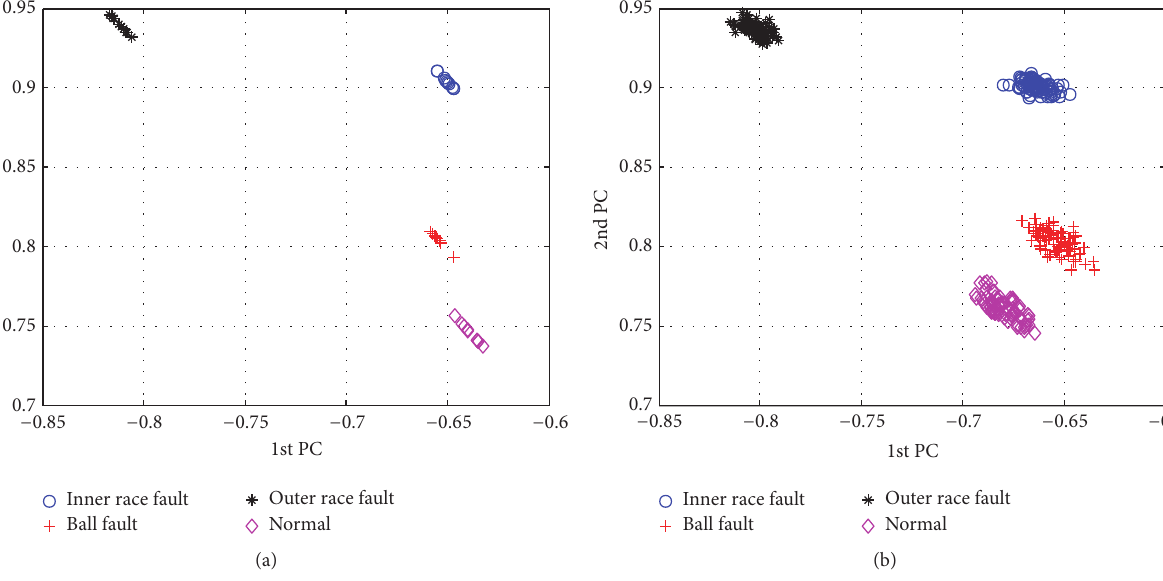
Figure 9: Feature extraction with MKMFA: (a) training set and (b) testing set.